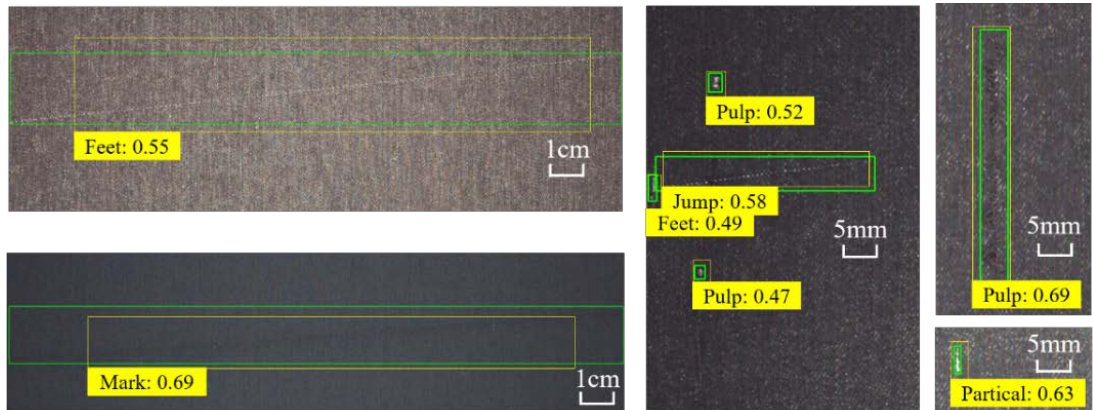
Figure 13. Visualization of the best bounding boxes of defects from MC-Net along with CI-FPN. Table 6. Performance of CG-RPN with different center-ness threshold tuples. Tuple